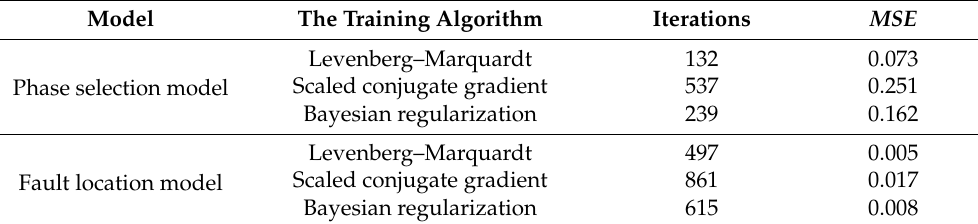
Table 2. MSE and iterations under different training